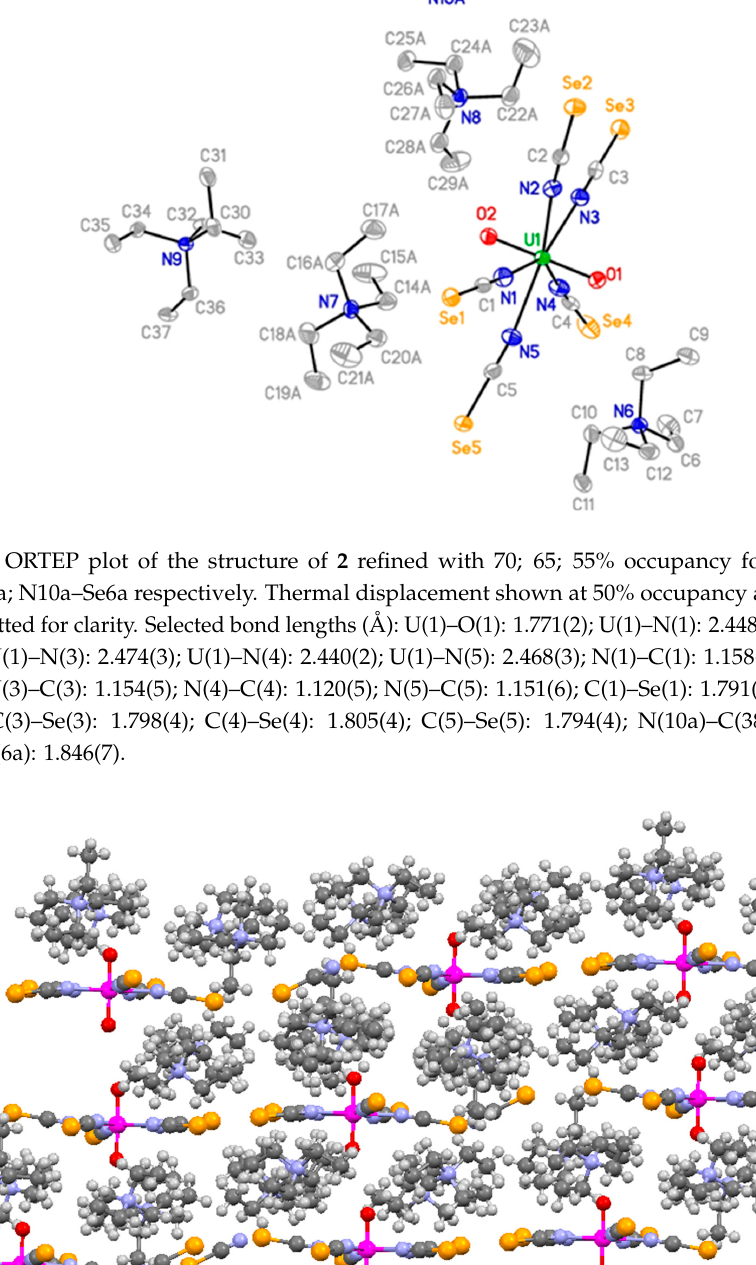
Figure 2. Packing diagram of 2 viewed down the a axis. Color code: U—pink; N—blue; C—Grey; S—yellow; O—red.